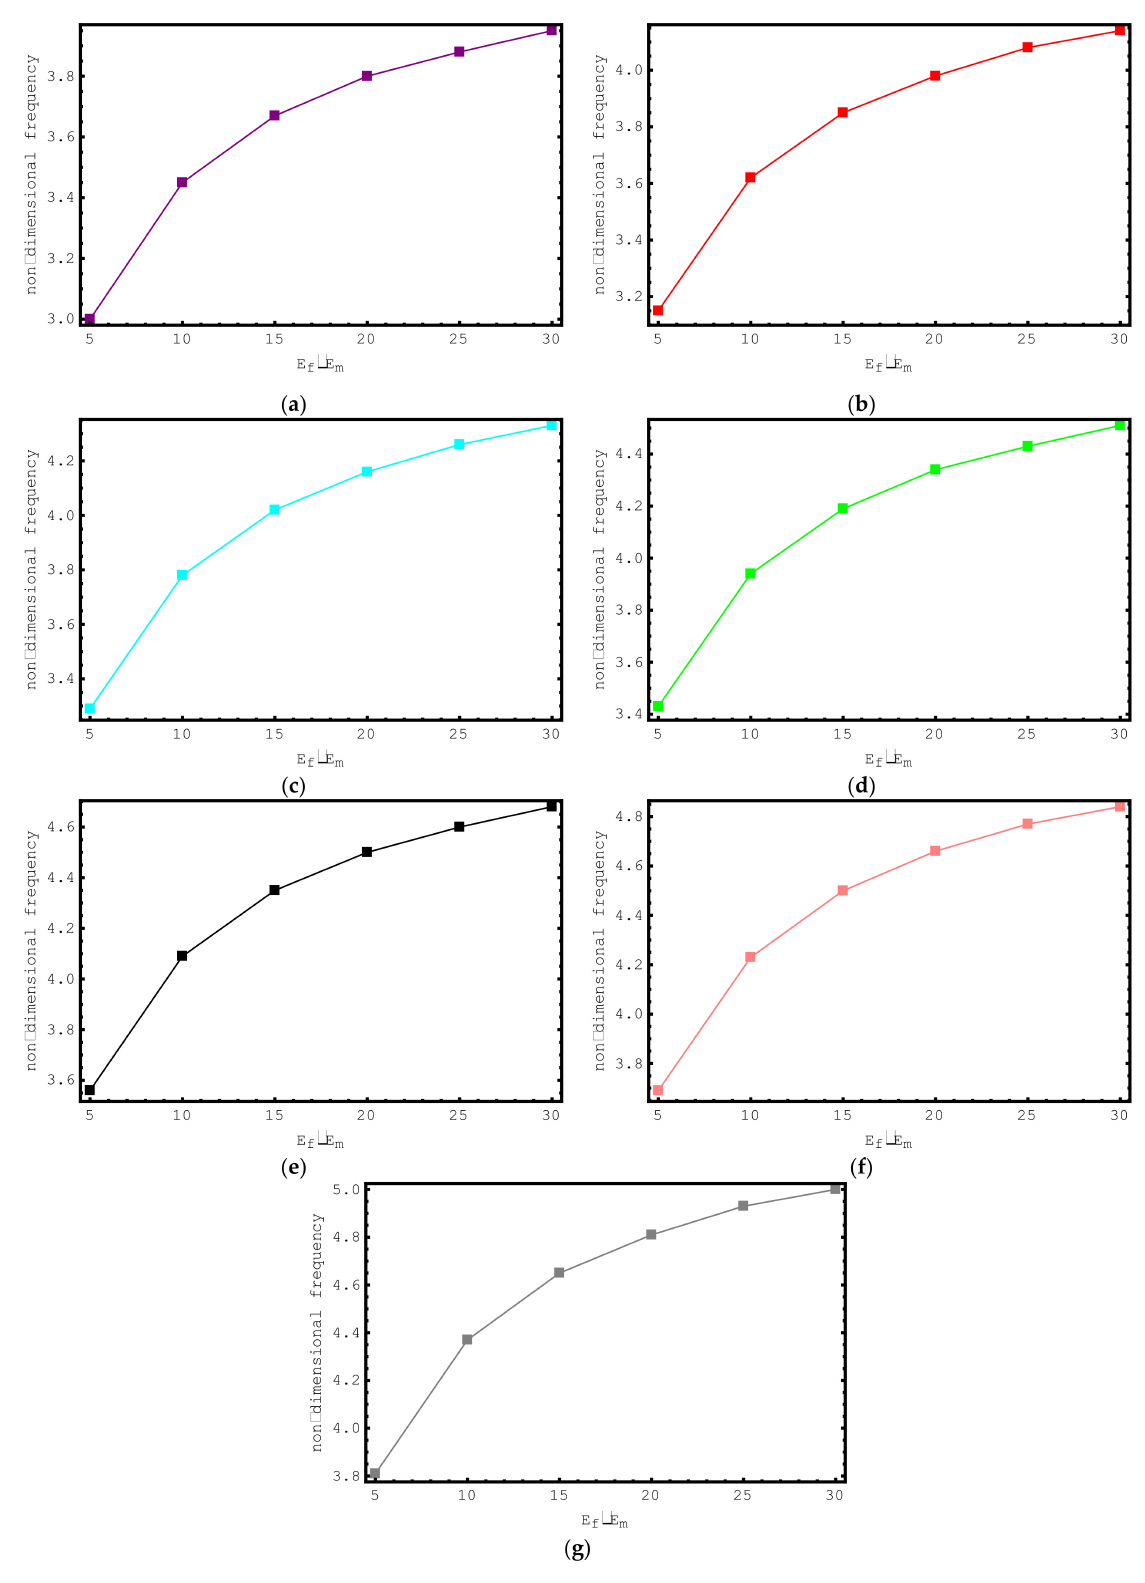
Figure 8. The variations of non-dimensional frequencies of short-fiber-reinforced composite nano- rods versus E f /E m : ( a ) K = 0 ( b ) K = 1 ( c ) K = 2 ( d ) K = 3 ( e ) K = 4 ( f ) K = 5 ( g ) K =